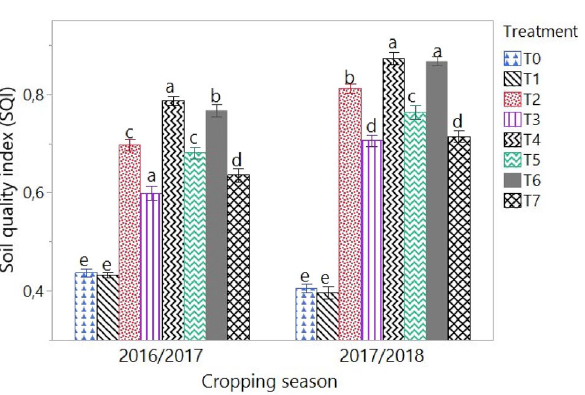
Figure 3. Variation in soil quality index (SQI) under different treatments in the 2016/2017 and 2017/2018 cropping seasons. T0 = control (no amendement), T1 = IF : 13-13-23 NPK at 450 t ha −1 + urea at 100 t ha −1 , T2 = TB at 20 t ha −1 , T3 = TB at 10 t ha −1 , T4 = PM at 20 t ha −1 , T5 = PM at 10 t ha −1 , T6 = TB at 10 t ha −1 + PM at 10 t ha −1 , T7 = TB at 5 t ha −1 + PM at 5 t ha −1 . TM Tithonia diversifolia fresh biomass, PM poultry manure, IF inorganic fertilizer. Values followed by similar letters are not significantly different at p =